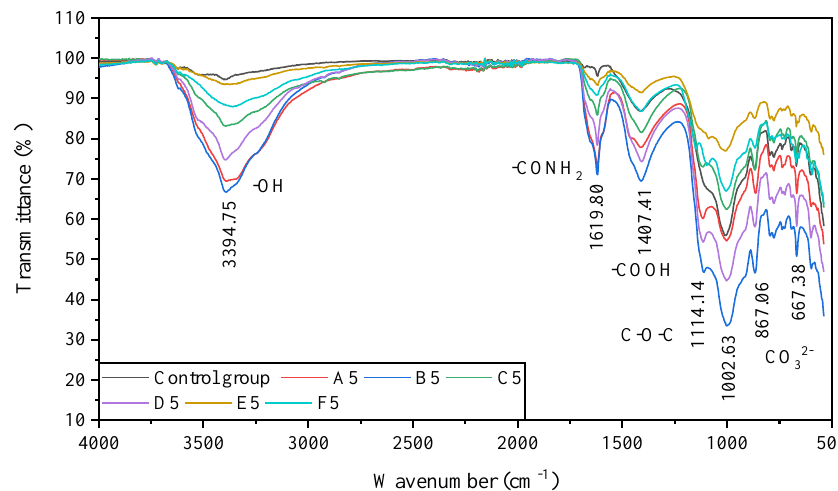
Figure 8. The FTIR results of samples with 0-6 rounds of grouting.